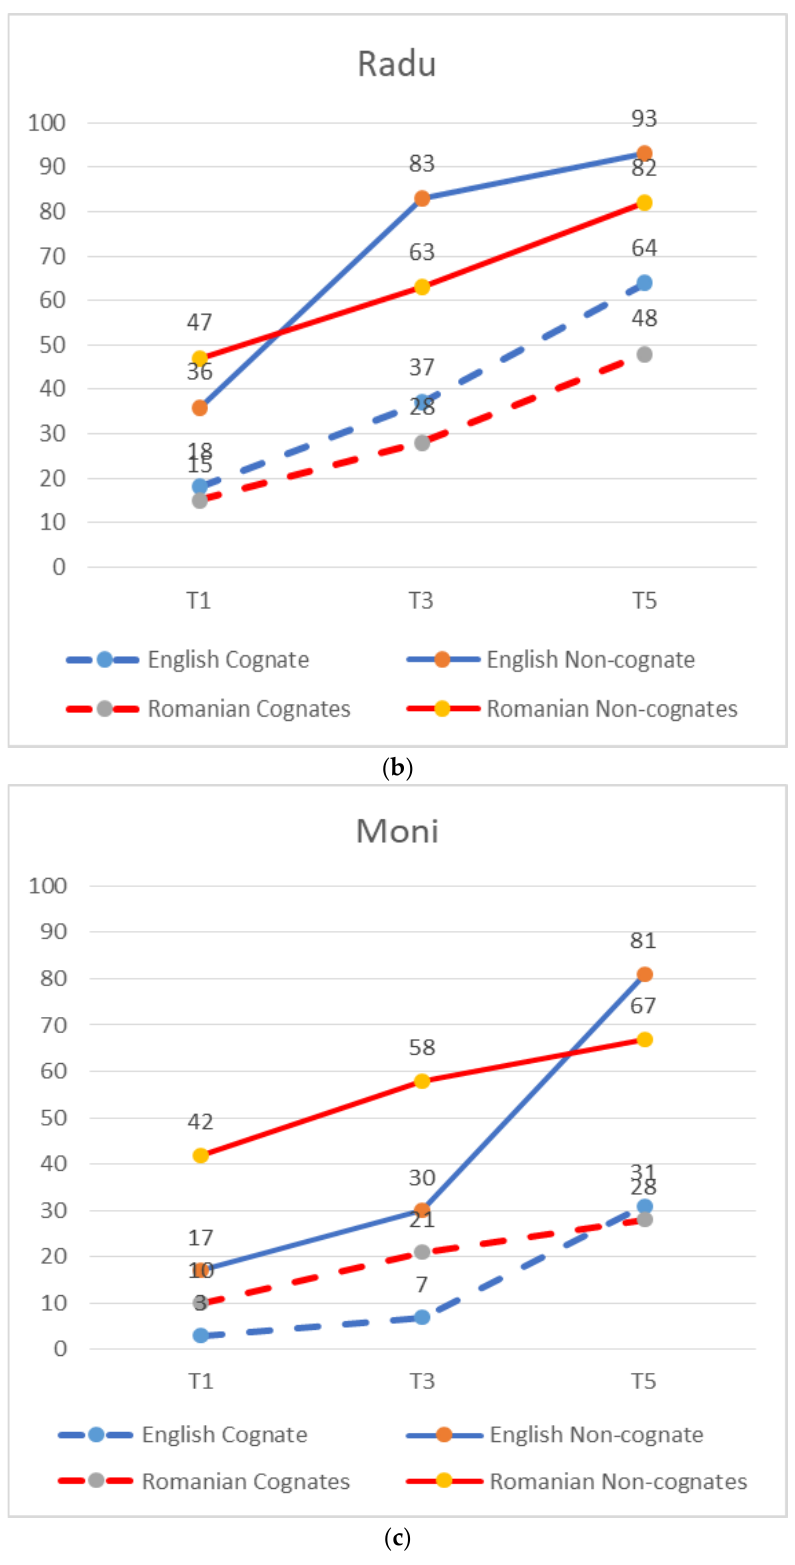
Figure 4. PPVT 4—Raw scores for cognate/non-cognate categories (max 70 and 122, respectively) for Romanian and English ( a ) for Dan; ( b ) Radu; and ( c ) Moni.